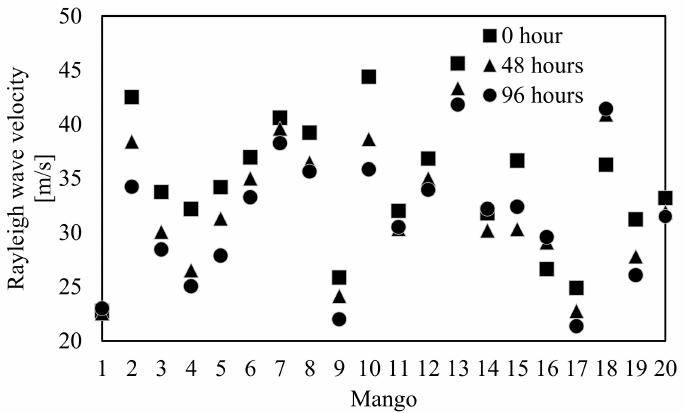
Figure 7. Shift in the Rayleigh wave velocity measured around Line A for mangoes 1–20 at 0, 48, and 96 h.